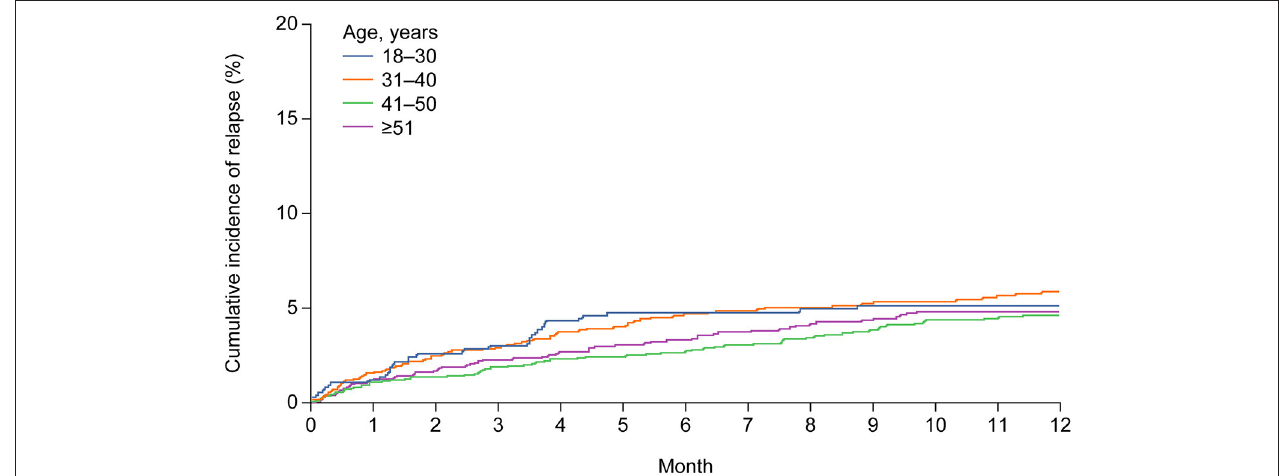
FIGURE 3 | Cumulative incidence of relapse during 1 year of follow-up, according to age group.